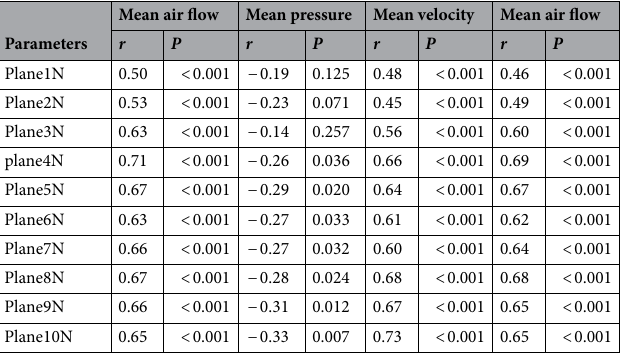
Table 3. Results of the correlation analysis of flow parameters in ten positions with the TDI